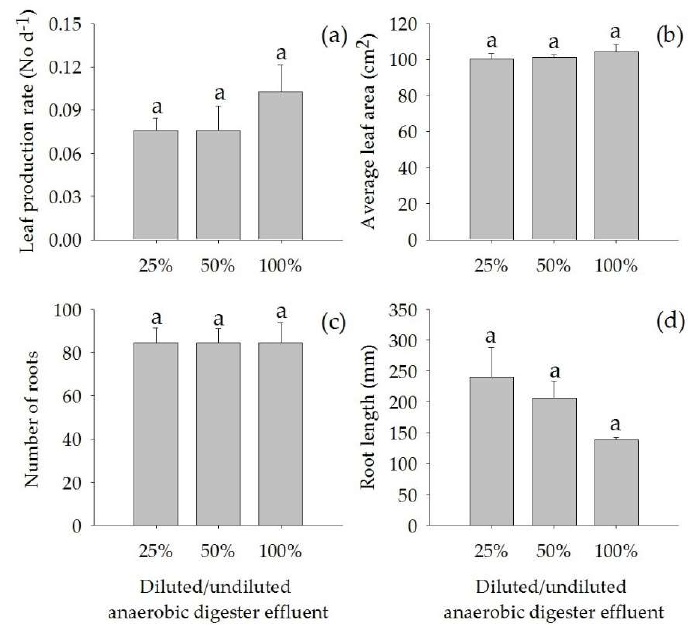
Figure 2. Leaf production rate ( a ), average leaf area ( b ), number of roots ( c ) and root length ( d ) (Mean ± SE) of Acorus calamus grown on diluted anaerobic digester effluent (25% and 50%) and undiluted anaerobic digester effluent (100%) for a period of 56 days.